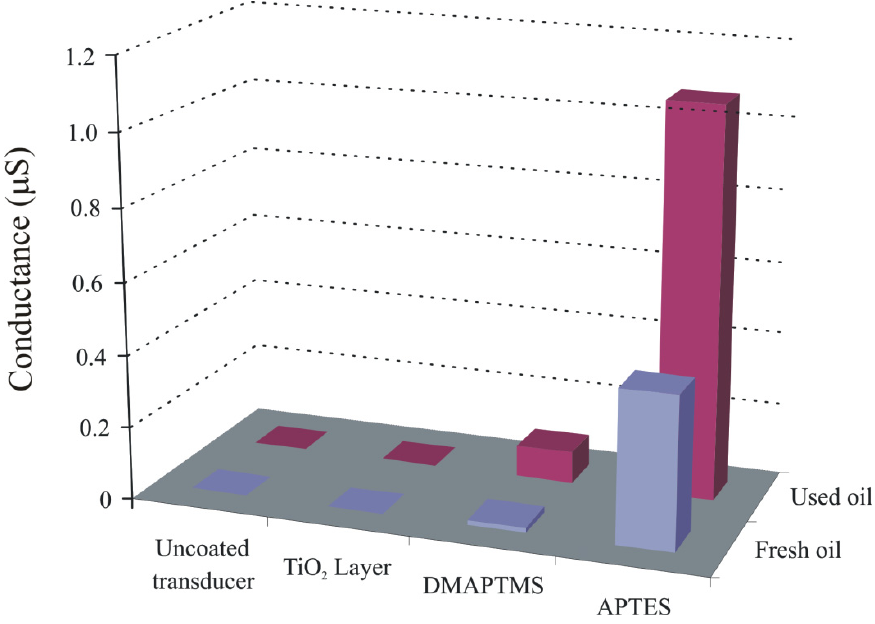
Figure 3. Normalized sensor responses of titania, dimethylaminopropyltrimethoxy silane (DMAPTMS), and aminopropyltriethoxy silane layers when exposed to fresh and 83 hours used oil samples. These responses are further compared with uncoated transducer